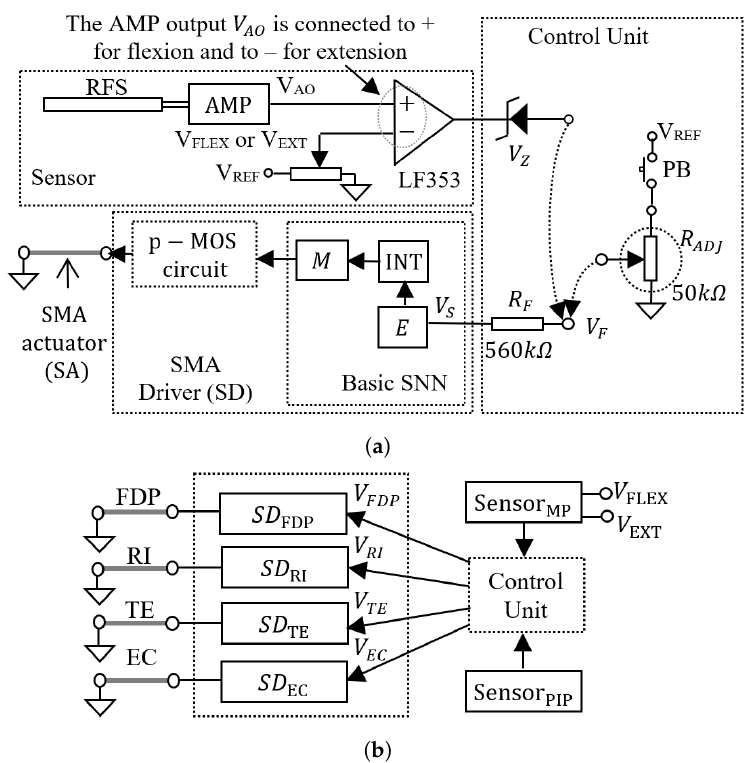
Figure 3. The structure of the SMA driver (SD) for a single SMA actuator control unit (CU) ( a ); the structure of the system that includes a SMA driver for each of the actuators FDP, RI, TE, and EC ( b ).